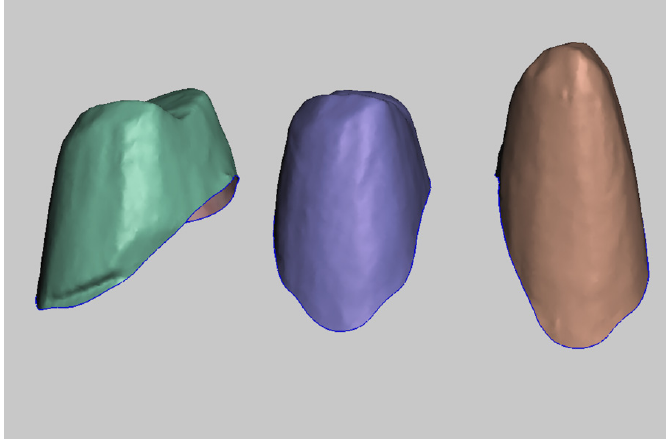
Figure 12. Coronal and median thirds derived from the intraoral digital impression.